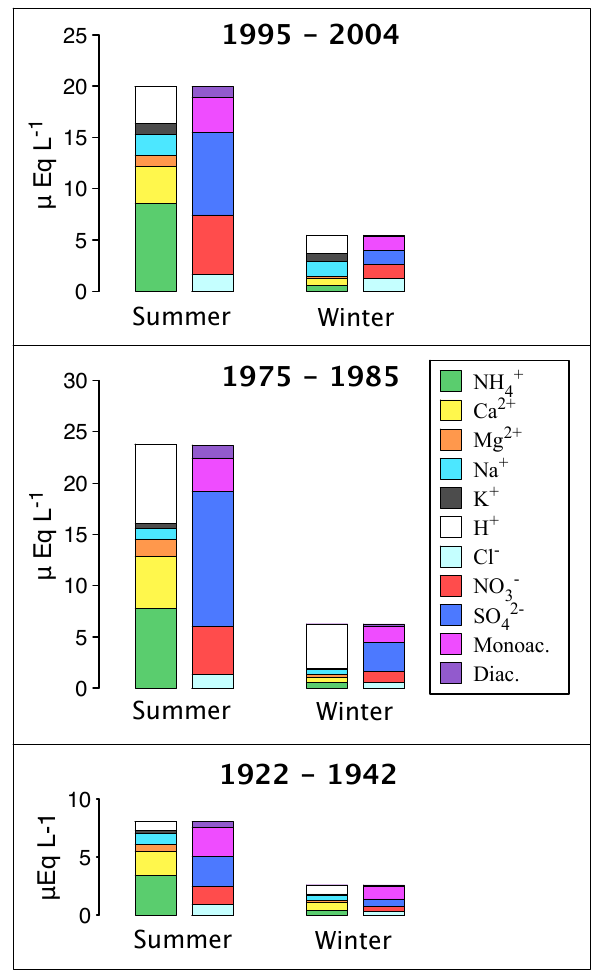
Fig. 5. Overall mean ionic composition of snow and ice layers de- posited in summer (left) and winter (right) over three different time periods in the CDK core. Abbreviations Monoac. and Diac. stand for C 1 –C 3 monocarboxylates and C 2 –C 5 dicarboxylates, respec- tively (see Eqs. 2 and 3 in Sect. 3.1). Individual summer and winter half-year means were calculated after having corrected data from the contribution of Saharan dust (see details in Sect.